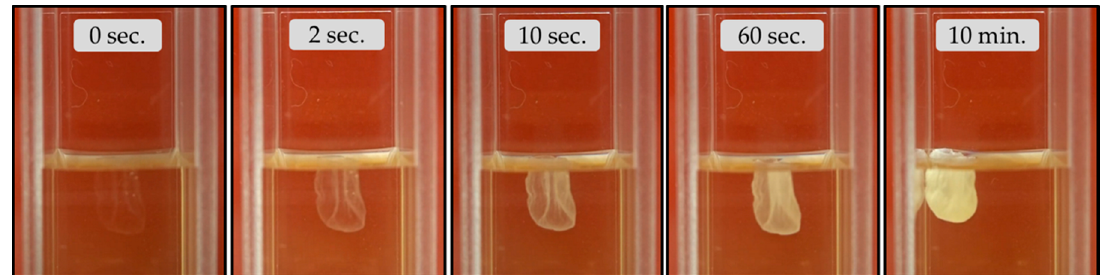
Figure 6. Temporal evolution of the morphology and texture of the barium carbonate Magadi vesicles. The width of the cuvette is 1.25 cm.